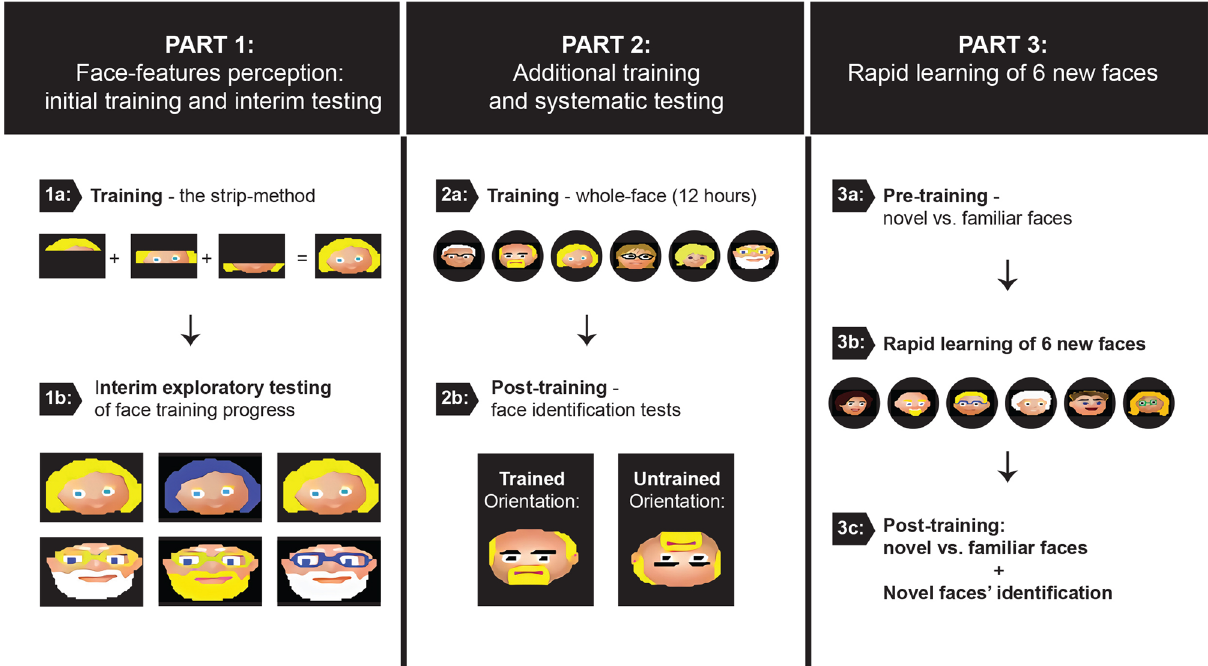
Figure 2. Experimental paradigm. The experiment was divided into three parts. First, participants underwent six hours of training, followed by interim testing of face identification and detection of changes to facial features ( 1b ). The strip-method was used in this first part: each face was divided into three horizontal strips representing the upper, middle, and lower parts of the face ( 1a ). To teach participants the composition of face parts and how to tune their hearing to perceive multiple tones at the same time, they were trained to perceived details within each strip. Following completion of this stage, participants were able to integrate their knowledge and perceive the complete face soundscapes. Second, participants underwent additional 6 h of whole-face training ( 2a ). They subsequently took part in several tasks designed to test face identification, including the identification of learned faces in the untrained, inverted orientation ( 2b ). Third, participants underwent an additional pre-post experiment, in which they quickly learned a new cohort of six faces and were tested on face identification before and after two hours of training ( 3a – 3c